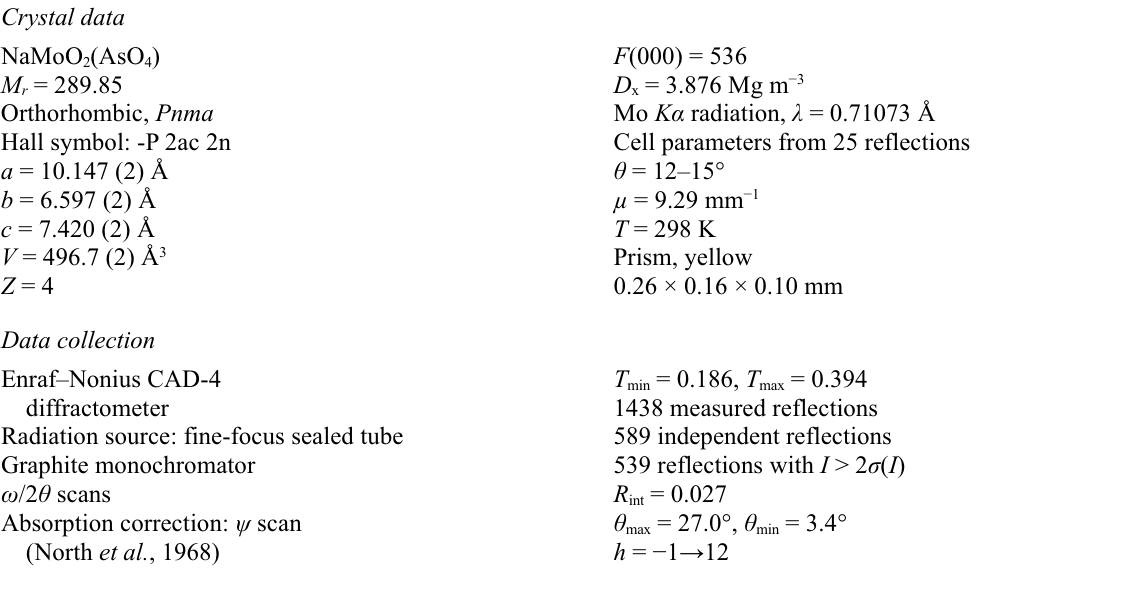
Figure 3 Projection de la structure de la variété β -NaMoO sodium dioxidomolybdenum(VI)